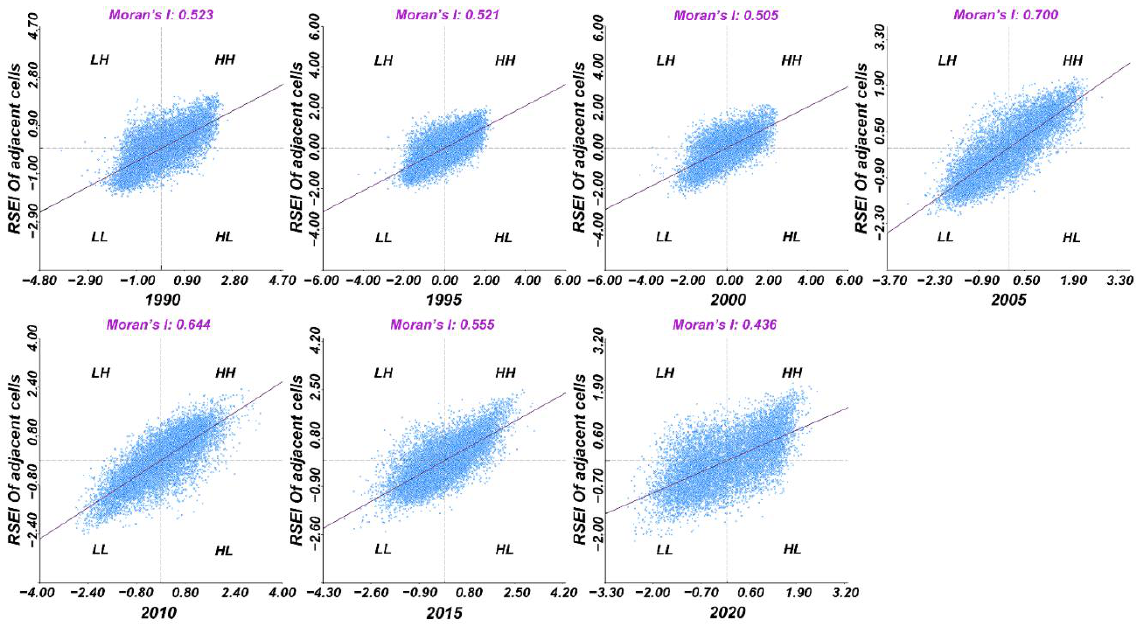
Figure 5. 3-D Scatterplot illustrate the relationships between WET, NDVI, LST, NDBSI, and RSEI. ( a ) The relationship among RSEI, NDVI and WET; ( b ) The relationship among RSEI, NDBSI, and LST.